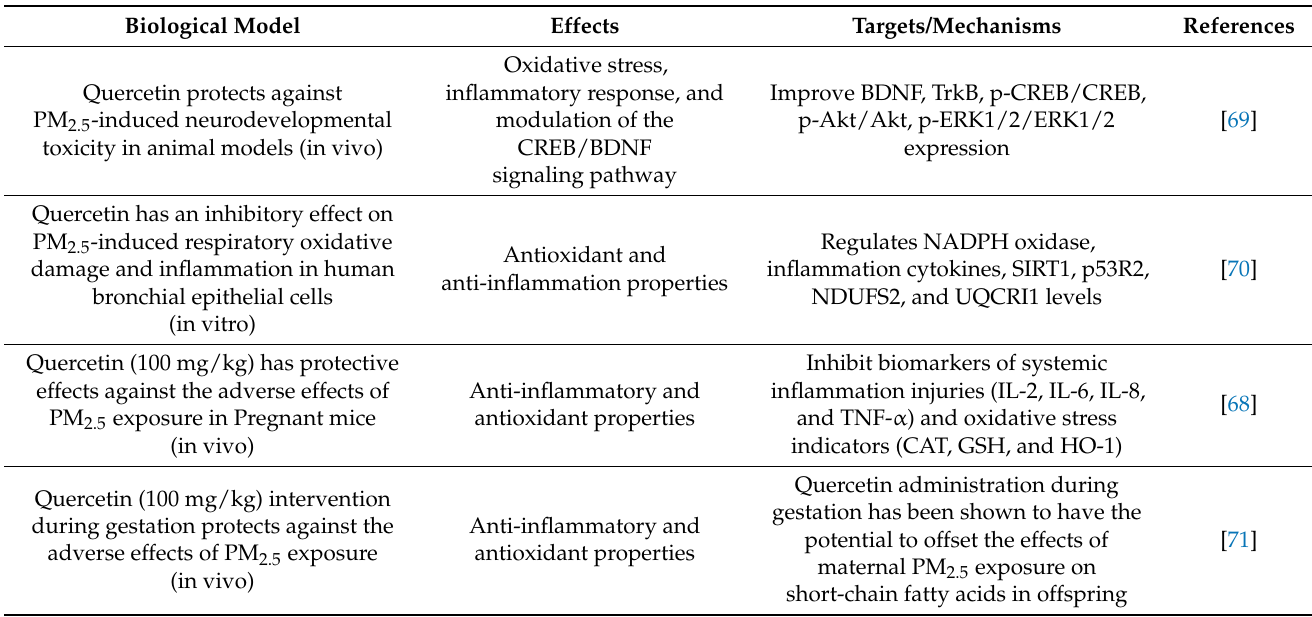
Table 4. Quercetin has been shown to have neuroprotective and anti-inflammatory effects in exposure to PM 2.5